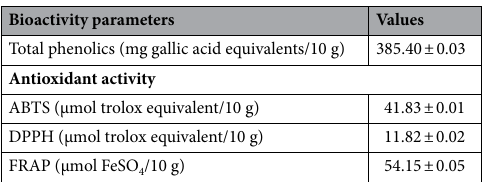
Table 1. Total phenolics and antioxidant activity in red-Jambo leaf extract.